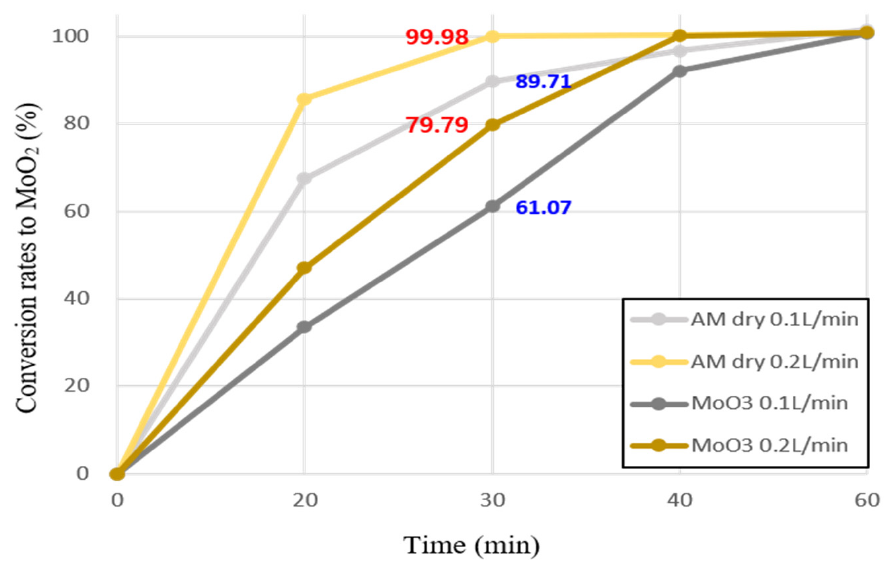
Figure 8. Variations in the rates of conversion to MoO 2 with hydrogen reduction time in the first stage of hydrogen reduction at 575 °C for (NH 4 ) 4 Mo 5 O 17 and MoO 3 .